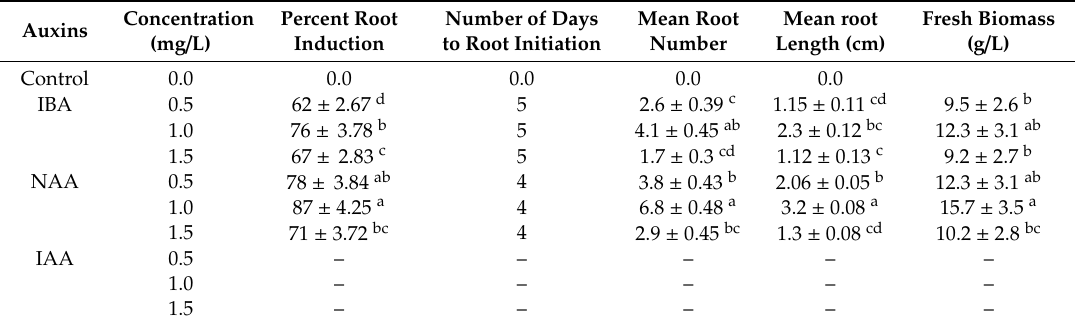
Table 1. Di ff erential response of adventitious rooting with varying concentrations and types of auxins growing on solid MS medium with 3% sucrose after four weeks of incubation.